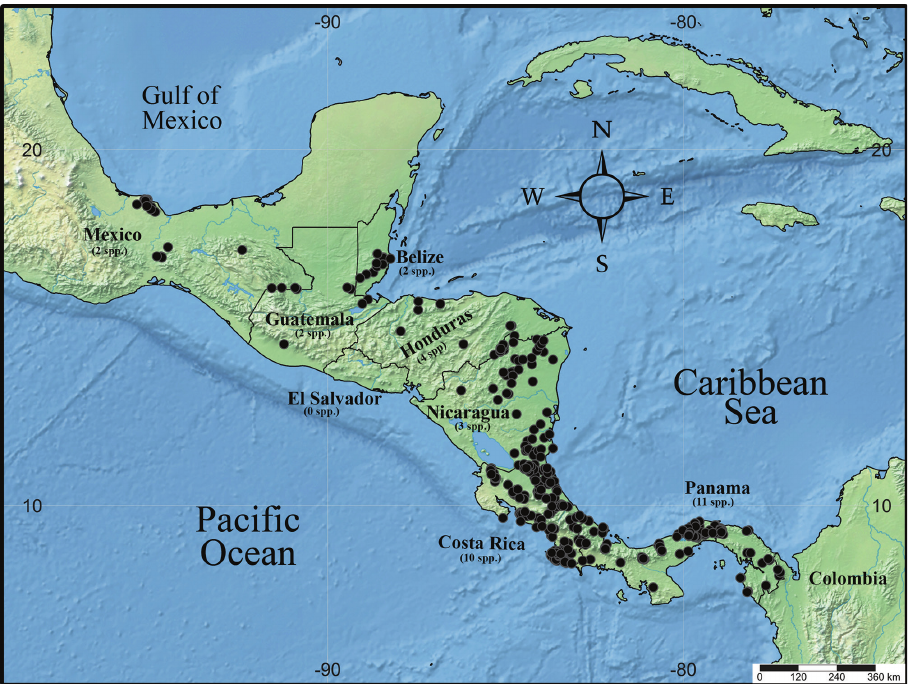
Figure 2. Geographic distribution of Virola in Mesoamerica, with the number of species native to each country indicated in parentheses below the country’s name.